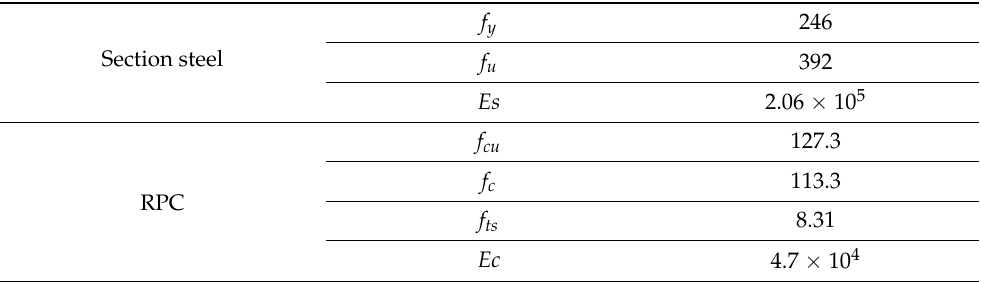
Figure 4. Size of beam cross-section (unit: mm). Table 1. Material performance parameters (unit: